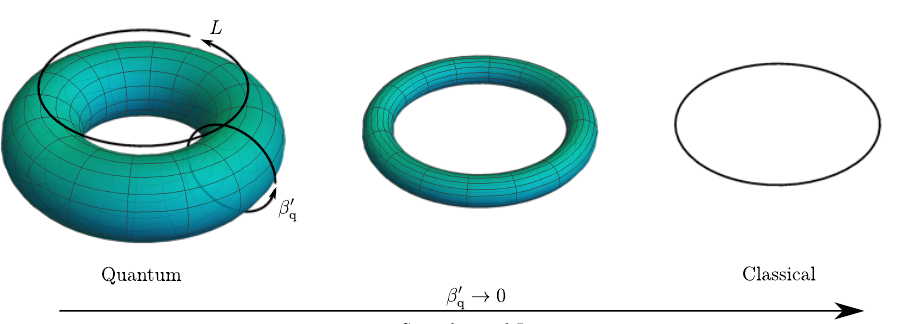
Figure 2: Graphical representation of the semiclassical limit of the thermal par- tition function. Within the path integral formalism, the partition function of the quantum Lieb-Liniger model can be represented as a classical partition function on a ] . Increasing the temperature, i.e. β (cid:48) → 0, the two-dimensional torus [ 0, L ] × [ 0, β (cid:48) q q transverse dimension of the torus shrinks until the torus collapses on a one dimen- sional ring, namely the domain of the path integral describing the classical partition function of the Non-Linear Schröedinger